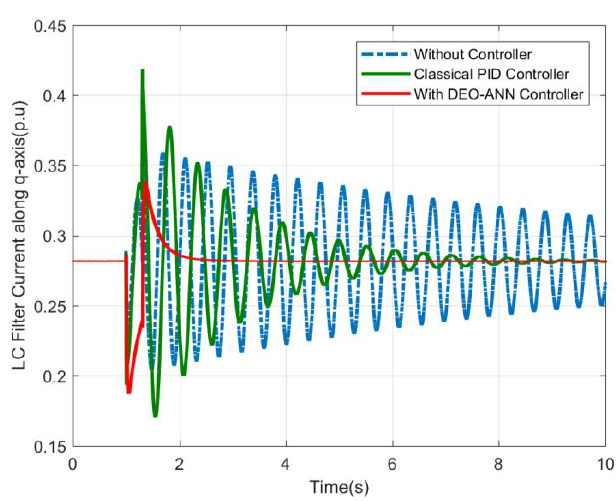
Figure 21. LC filter output current along the q-axis.